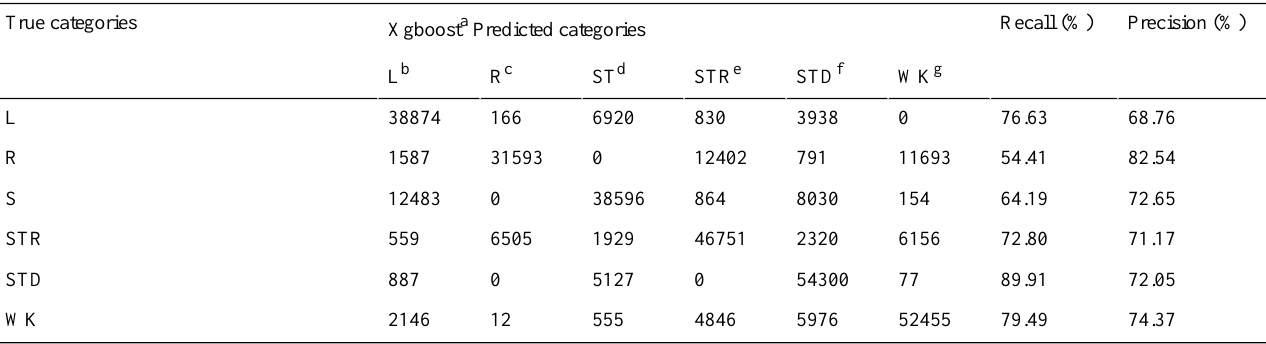
Table 2. Confusion matrix of instantaneous predictions using greedy Gaussian segmentation from the 2 test experiments in the BREATHE